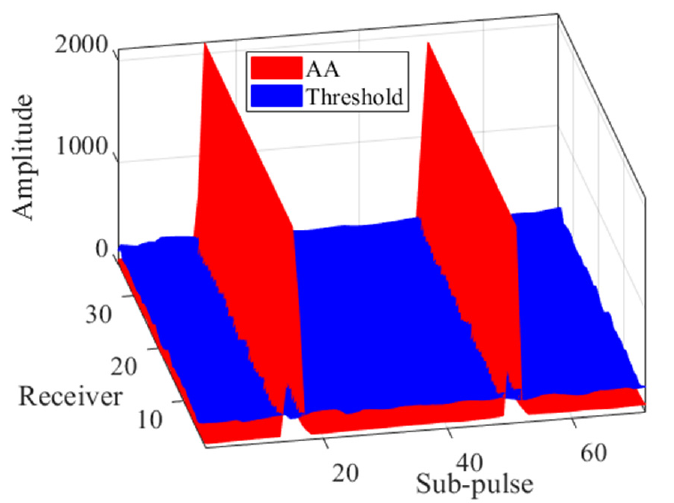
Figure 11, for the first transmitting antenna, the AAs corresponding to different sub-pulses and receiving antennas are shown by the red surface in Figure 13. It can be seen that the WBI-interfered sub-pulses are clearly indicated by the AA values. Hence, either based on an empirical threshold or an adaptive threshold, Γ C can be easily obtained, as shown in I Figure 13, where the SO-CFAR algorithm with a guard cell number of 4, a false alert rate of 10 − 3 , and a reference cell number of 8 is used to determine the detection threshold (i.e., the blue surface).